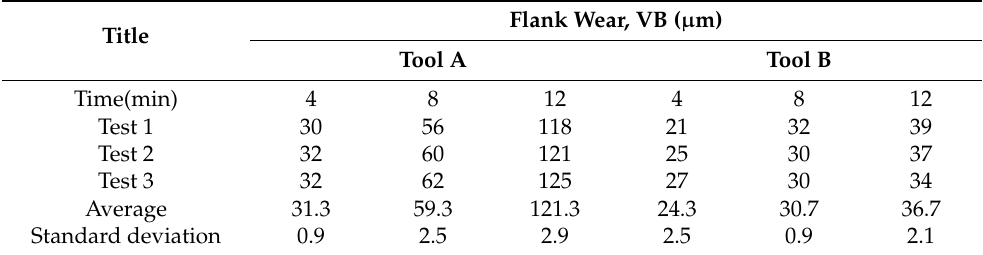
Table 4. Partial data and analysis of tool flank wear width.